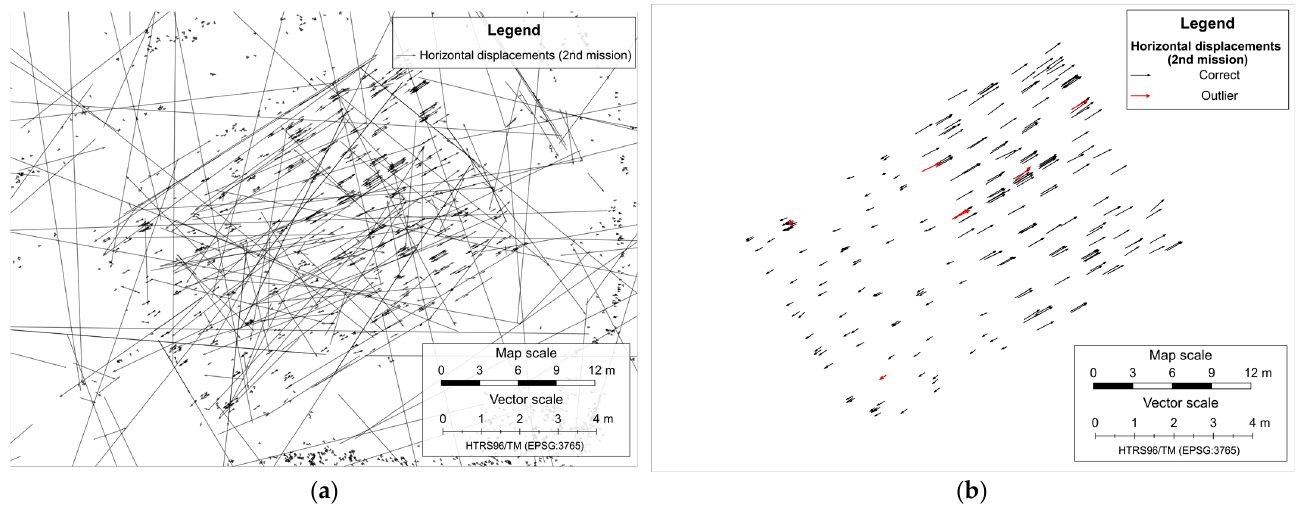
Figure 9. Remaining horizontal displacements vectors in the second mission after the filtering ( a ), correct and final displacement vectors with highlighted outliers in the second mission ( b ).